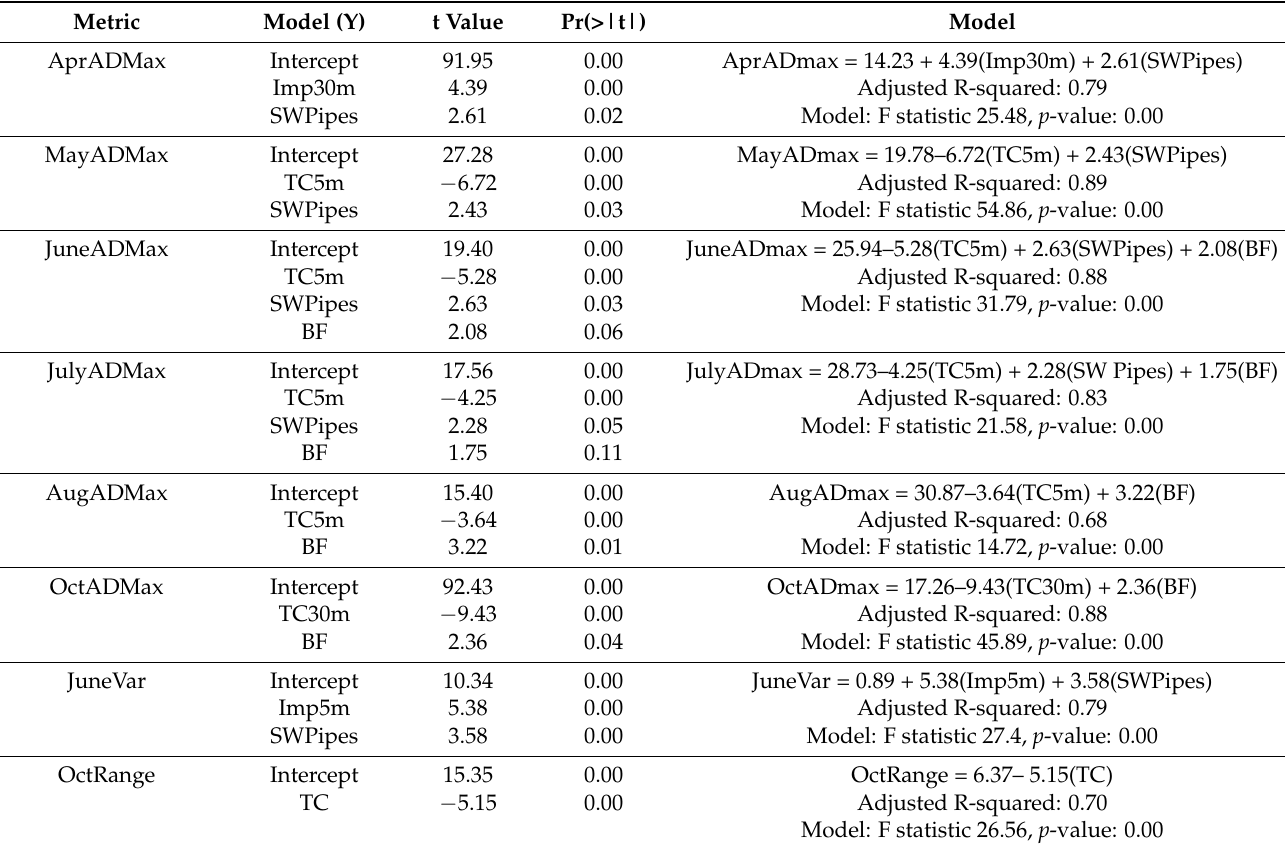
Table 6. Mixed-effects models to predict water temperature metrics for magnitude of change and variability based on April to October 2016 data for 14 study sites. The average of daily maximum water temperature per month (Monthly ADMax), maximum range per month, and variance of the mean daily water temperature per month are designed to quantify the magnitude and variability in water temperature change per month for aquatic species in urban streams with 4 to 62% impervious land cover. The models listed in this table are the final, best fit model to predict each metric after testing 6 candidate models per metric. The predictive variables included in the best fit predictive models for monthly ADMax are variable by month, suggesting that sources of variability in urban stream habitats may affect aquatic species differently during times of spawning (April to May), growth of early life stages (June), and times typically most thermally stressful (July to August). Final candidate models to predict water temperature variability were only significant for June variance and October